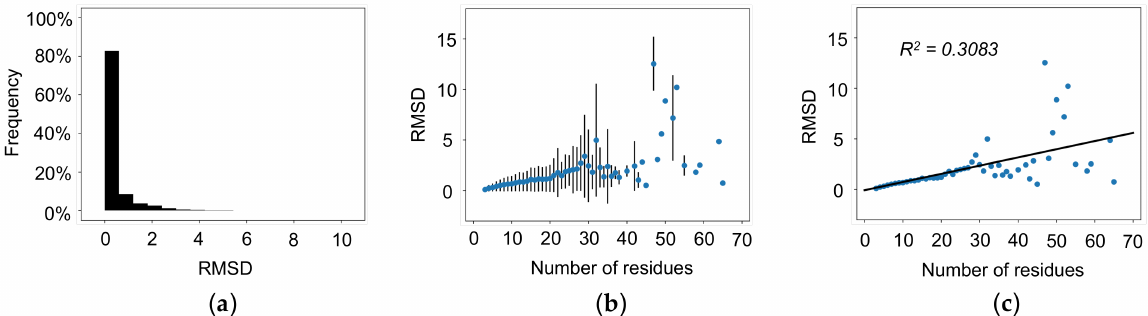
Figure 2. RMSD of AlphaFold 2 predicted structures with the equivalent experimentally determined structure as a template. ( a ) RMSD of all loops region. ( b ) Average RMSD as a function of the number of residues in a loop with standard error bars. ( c ) Average RMSD as a function of the number of residues in a loop with linear regression (R 2 = 0.3083). RMSD increases as the number of residues in the loop regions